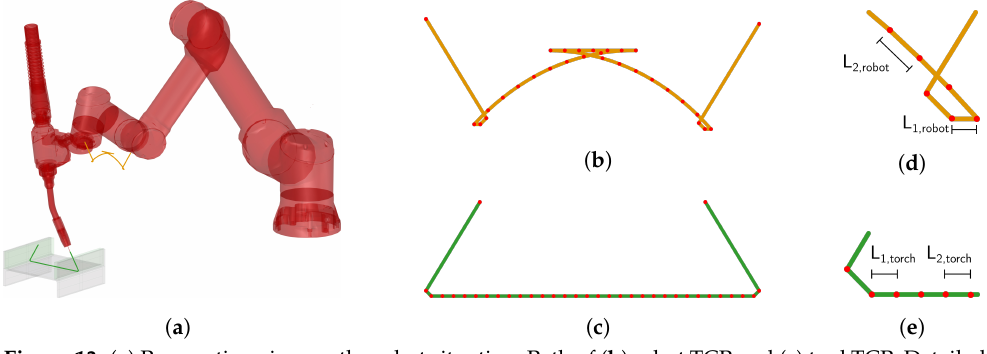
Figure 13. ( a ) Perspective view on the robot situation; Path of ( b ) robot TCP and ( c ) tool TCP; Detailed corner and distance between waypoints of ( d ) robot TCP and ( e ) tool